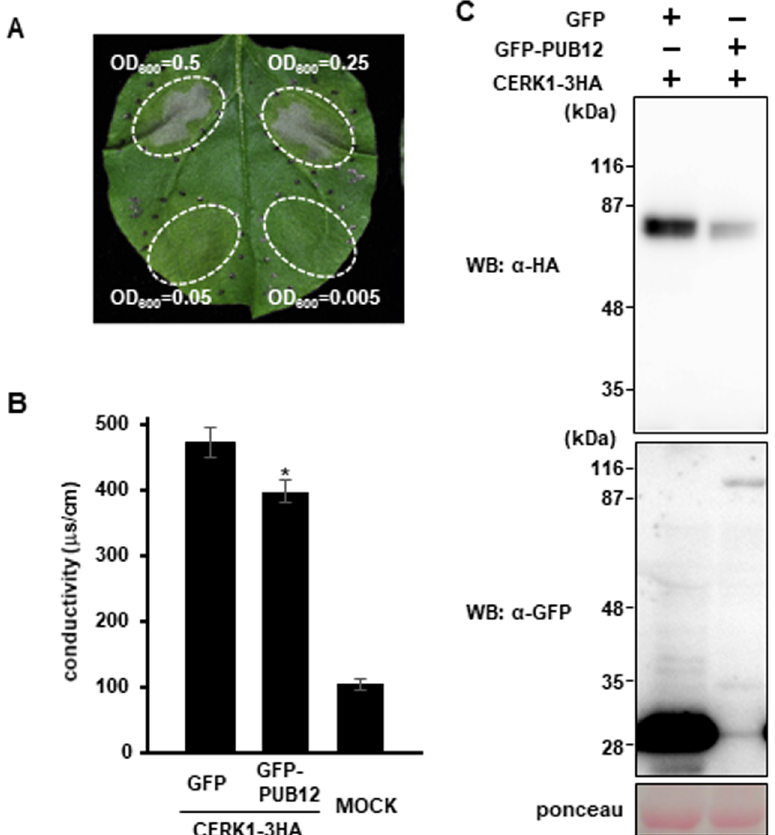
Fig 3. Expression of PUB12 reduces CERK1 protein levels. (A) The overexpression of CERK1 induces pathogen-independent cell death in Nb leaves. Cell death in infiltrated Nb leaf areas overexpressing CERK1- 10MYC was assessed3 days post-infiltration (dpi). (B) PUB12 suppressesCERK1-inducedcell death. Ion leakagein the infiltrated leaf areas co-expressing GFP or GFP-PUB12 with CERK1-3HAwas measuredat 2 dpi. Infiltration was performed using a blunt syringe at OD600 = 0.5 for all samples. The MOCK treatment with water was used as an internalcontrol. Data are the mean ± SE (n = 10). The asterisk indicatessignificant differences from GFP by the Student’s t -test ( P < 0.05). (C) Reductionsin CERK1 protein levels by PUB12. Nb leaves were infiltrated with Agrobacterium tumefaciens strains to co-express GFP (OD600 = 0.05)